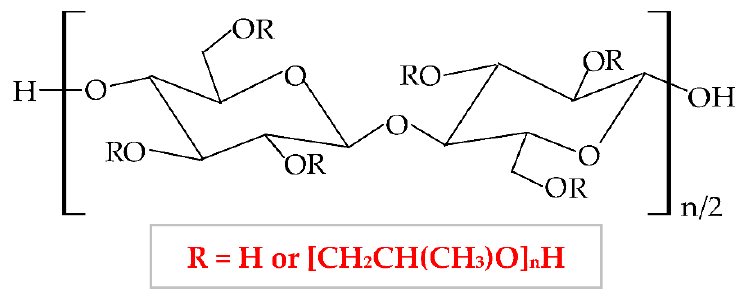
Figure 12. Chemical structure of hydroxypropylcellulose (HPC).